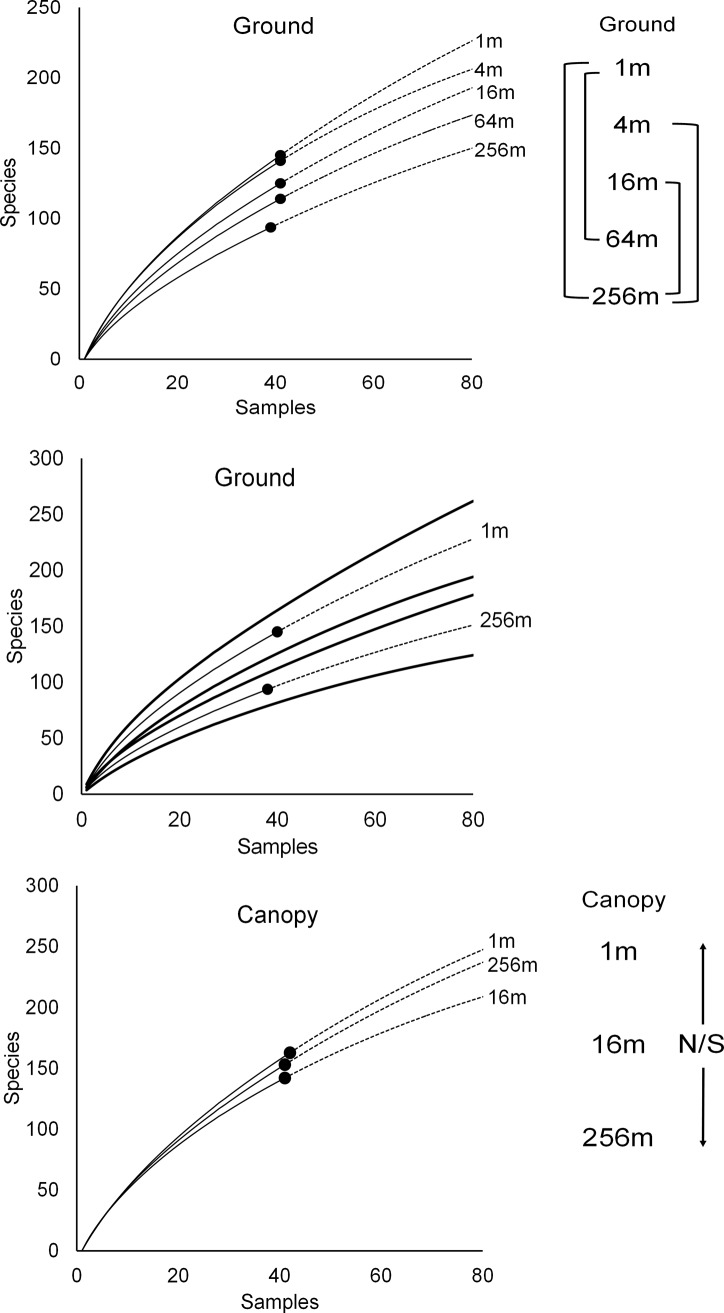
Sample-based species accumulation curves.The sample N = 40 trap-week X site combinations; with sampling endpoints shown by closed circles, then extrapolated (using dashed lines) to N = 80; significant differences are indicated by connecting lines in diagrams to the right. (top panel) Mean ground-level curves for each edge distance; (middle panel) 84% confidence intervals of significantly different curves at 1 m and 256 m from the edge; (bottom panel) mean canopy-level curves.